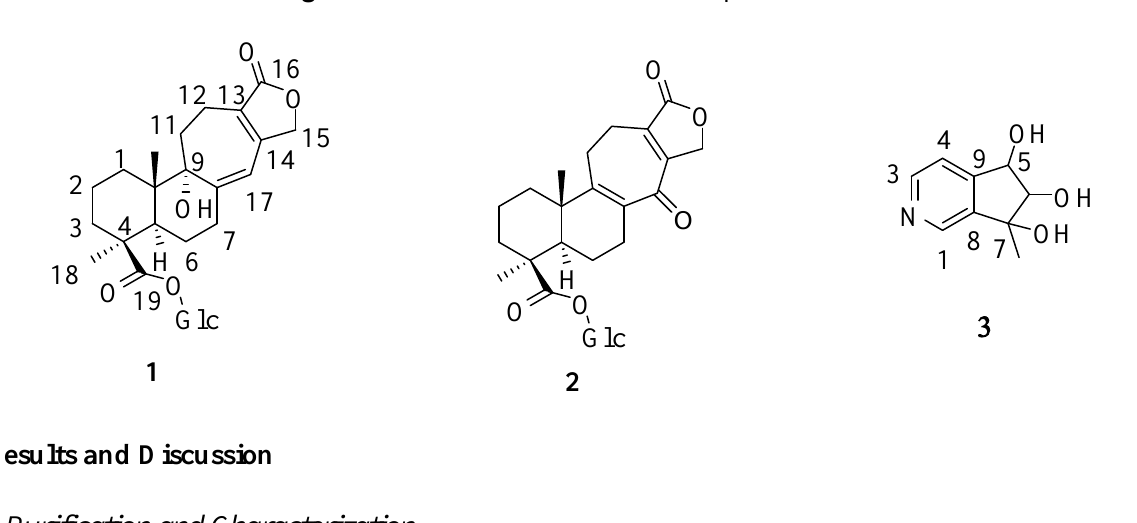
Figure 1. Structure of three new compounds 1 – 3